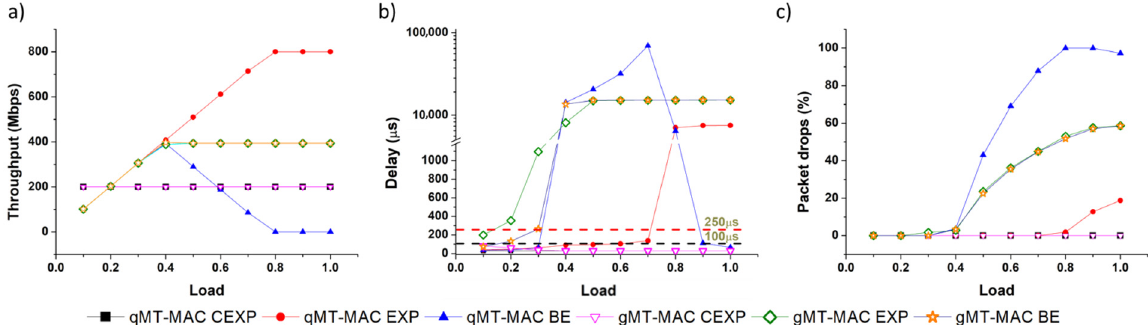
Figure 7. Performance evaluation vs. load for three combined flows (CEXP, EXP, and BE). Figure 7b displays the average delay vs. load for both protocols and all traffic